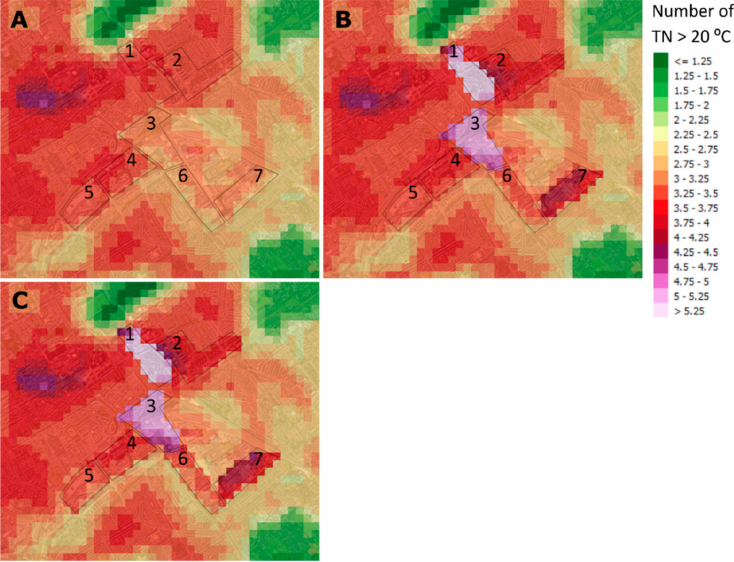
Figure 10. Modeled number of nights above 20 ◦ C per year for the CID in the current climate for ( A ) current housing, ( B ) constructing high-rise buildings whereby green spaces are preserved as much as possible, and ( C ) constructing high-rise buildings whereby the vegetation fraction is